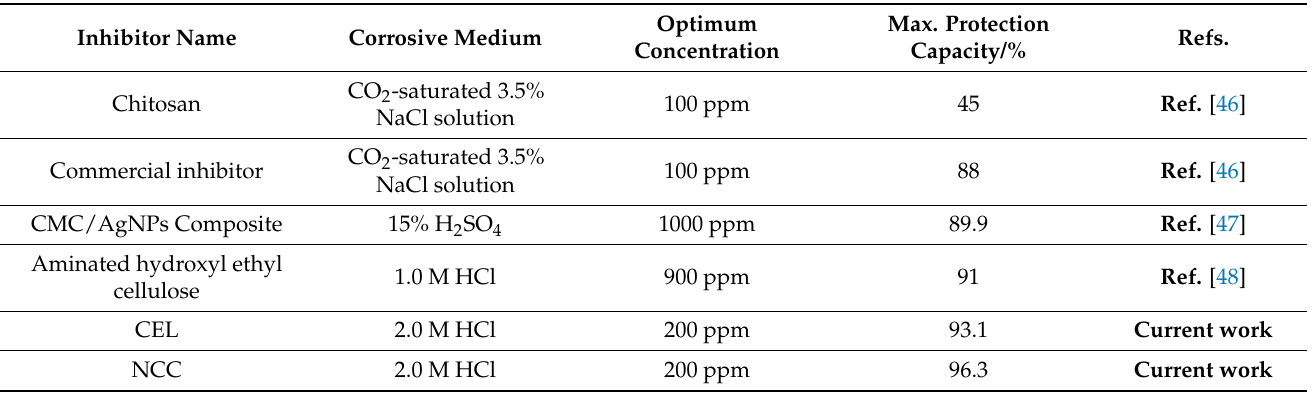
Table 3. Comparison of the corrosion protection capacity of the as-fabricated CNC, Cu-M@CNC, and Ni-M@CNC nanocom- posites on steel alloys with some previous